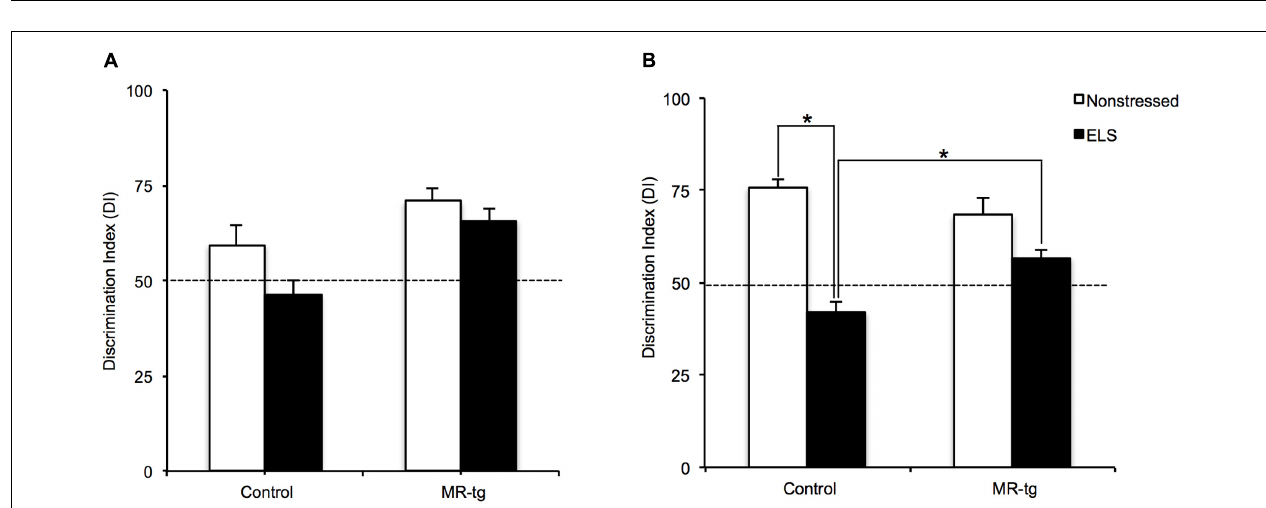
FIGURE 1 | Effect of ELS on bodyweight. (A) Body weight gain during the period of ELS (PND2-PND9, n = 23–25) and (B) at discrete time points; upon weaning (PND23), at PND39 and at PND120 (initiation of behavioral testing). Data are expressed as mean ± SEM with p -values based on post hoc LSD. n = 7–12 mice per group. ∗ Significant, p < 0.05.